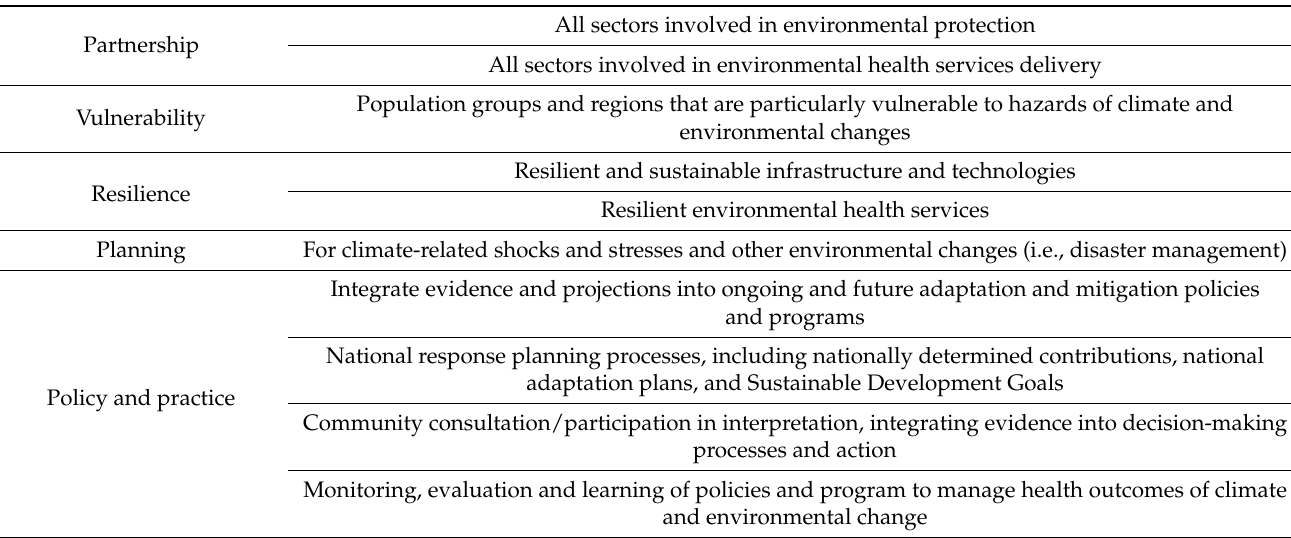
Table 5. Sub-competencies for Domain 4: Iterative risk management.